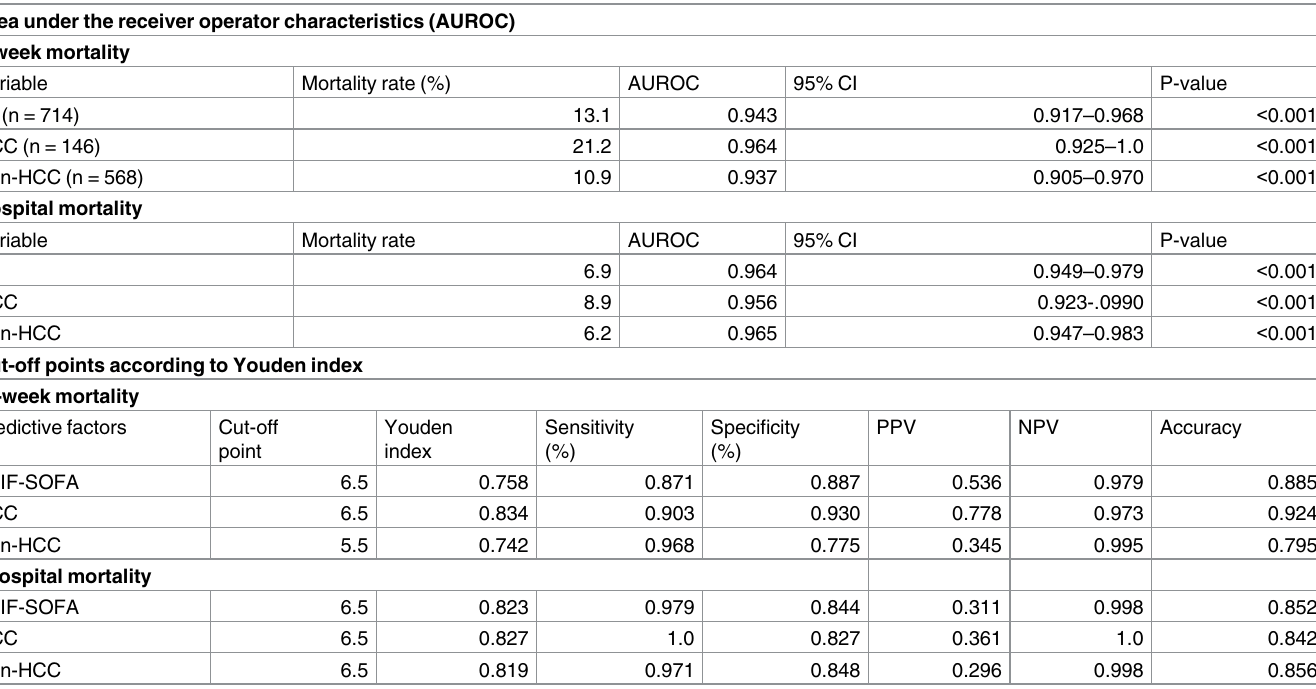
Table 4. CLIF-SOFA score according to history of